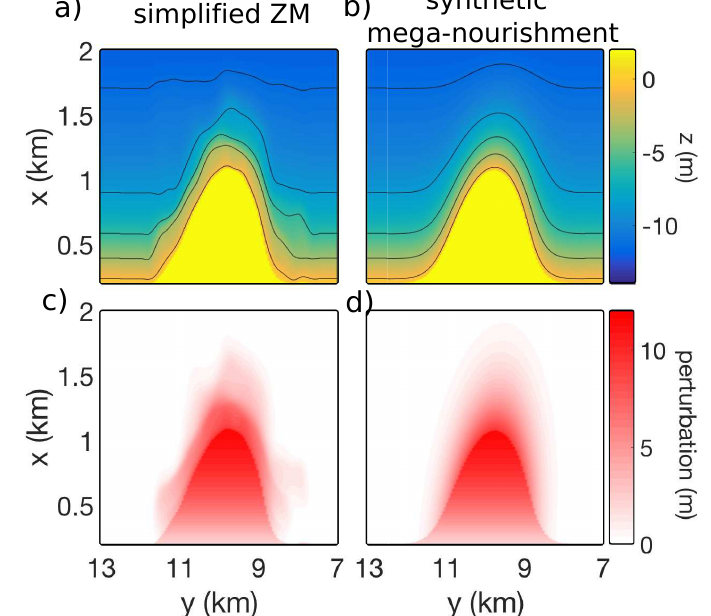
Figure A1. Simplified Zandmotor bathymetry (SZM) obtained from measurements (17 January 2012) ( a ) and synthetic mega-nourishment bathymetry (SMN) adjusted from a Gaussian-shape function ( b ), both with the dry beach set to 2 m; and ( c , d ) their respective associated bed level perturbations. Once the best parameter values are obtained, the corresponding perturbation is added to the idealized alongshore-uniform bathymetry. Herein, the dry beach is set to 2 m (averaged